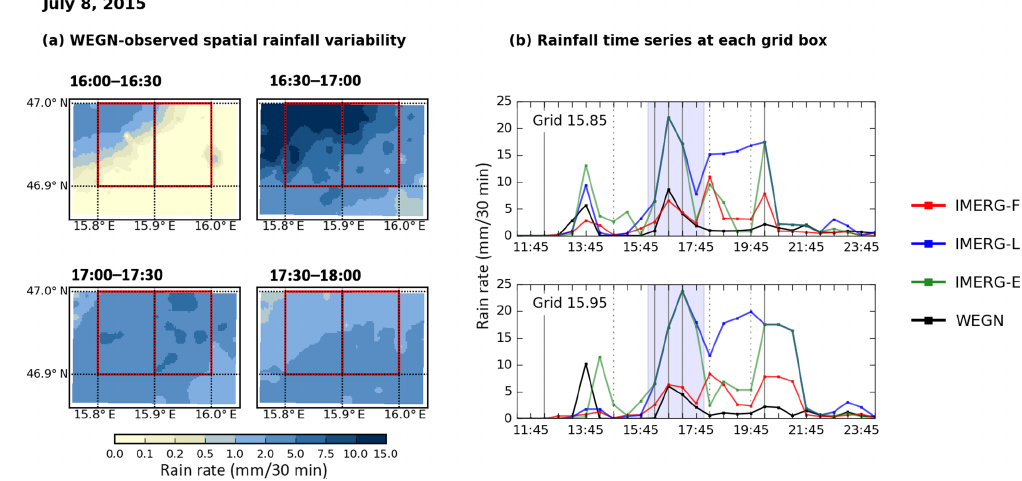
Figure 8. Same as Fig. 7, but for an example rainfall event in the hot season that occurred on 8 July 2015.